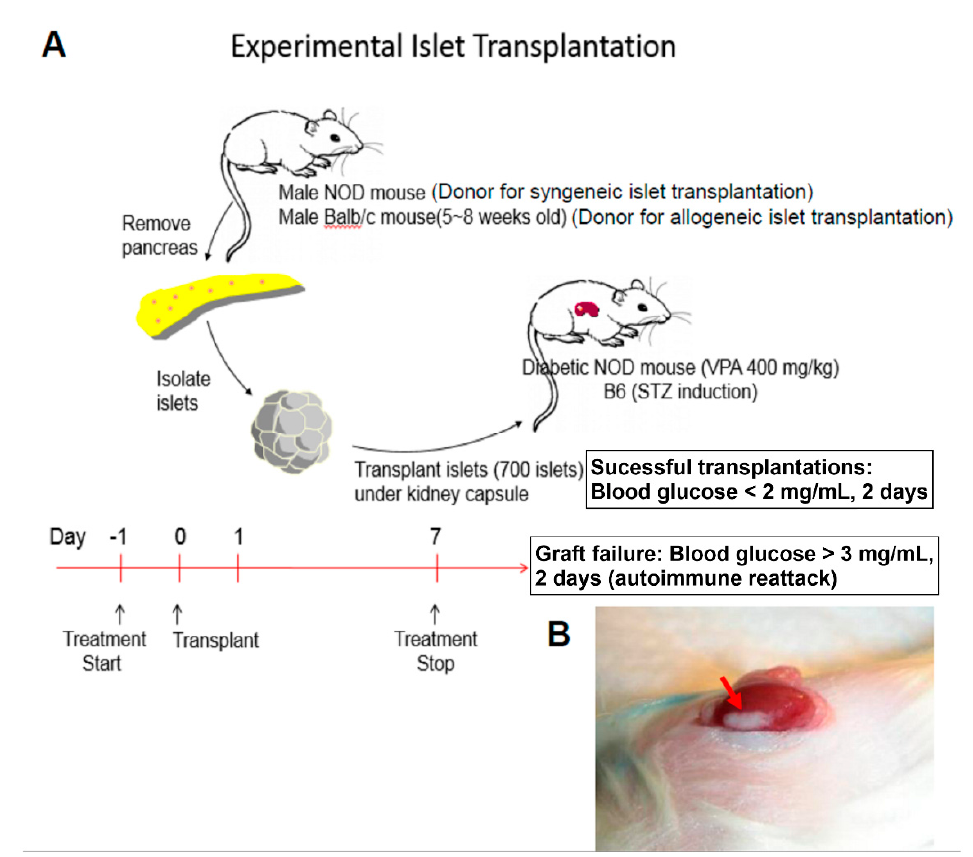
Figure 1. Syngeneic or allogeneic islet transplantation were performed to treat diabetic recipients. ( A ) Newly isolated islet from male NOD or Balb/c mice were transplanted into the kidney subcap- sular space of newly diabetic NOD or streptozotocin (STZ) − induced diabetic C57BL/6 recipients, respectively. Valproic acid (VPA) treatment prolonged islet graft survival in the syngeneic and allogeneic islet transplantation of non − obese diabetic (NOD) or C57BL/6 mice. The recipients were treated with nine dosages of VPA 400 mg/kg. ( B ) The red arrow indicates the presence transplanted islet graft in the subcapsular space of NOD recipients’ kidney.